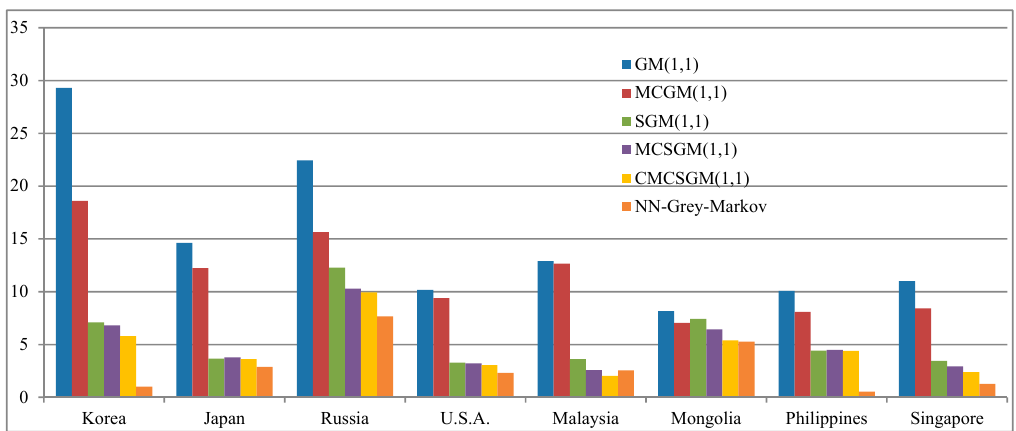
Figure 3. Model-fitting results for Case II.